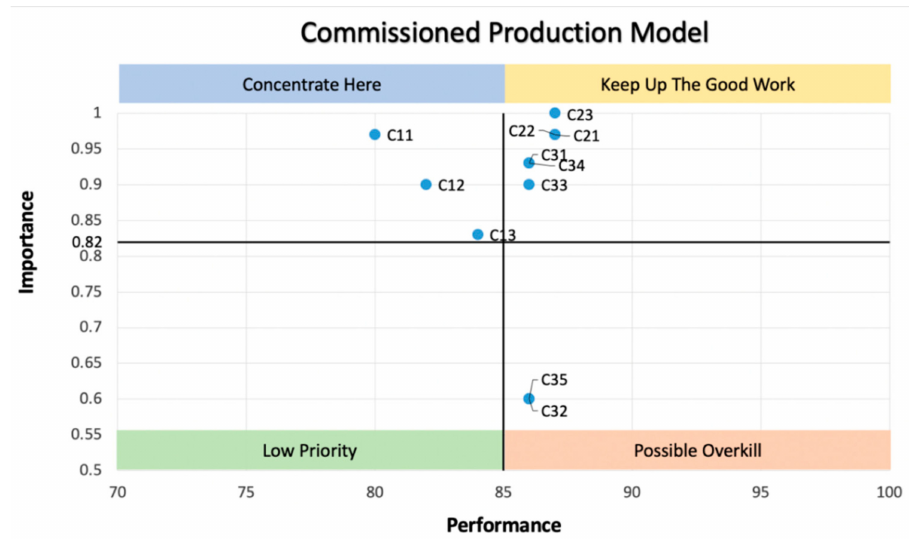
Figure 3. Importance–Performance Grid of Commissioned production model.